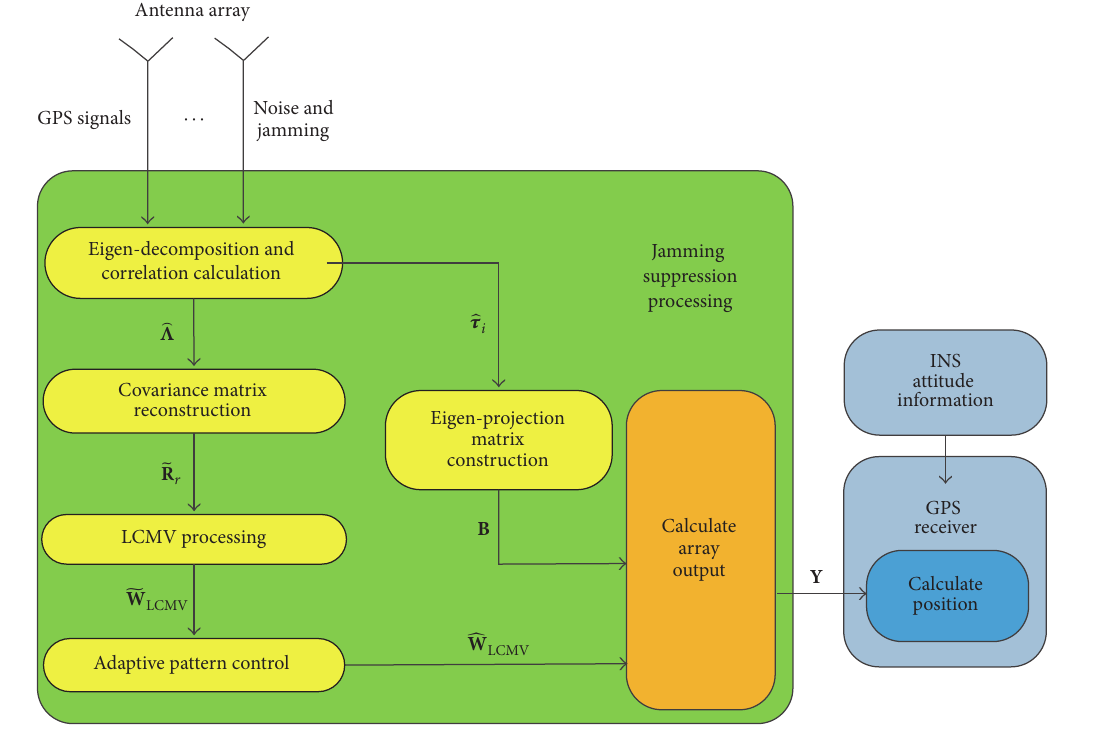
Figure 4: The flowchart of the proposed method.